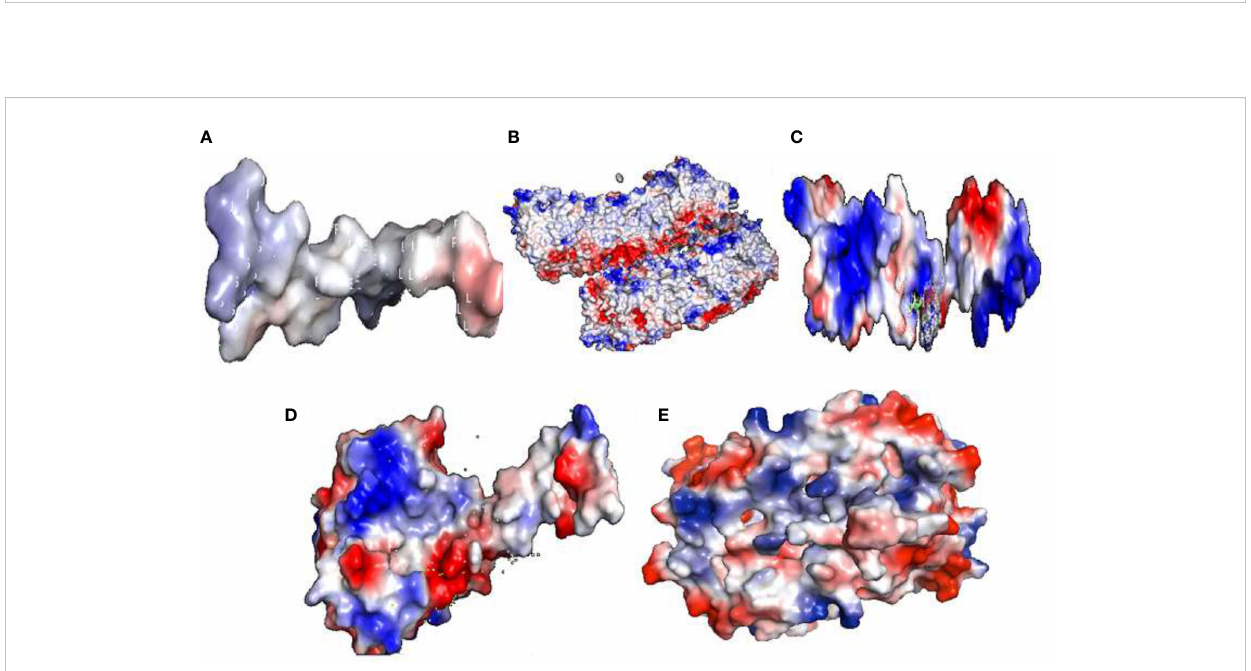
FIGURE 3 Electrostatic potential: surface electrostatic charge of (A) Ds-DbRCaG-07-Rga1p, (B) Ds-DbRCaG-08-Rga4p, (C) Ds-DbRCaG-09-Rga9p, (D) Ds- DbRCaG-10- Rga13p, and (E) Ds-DbRCaG-11-Rga15p calculated by PyMOL. Positive charges are shown in the blue region, negative charges in the red region, and neutral charges in the white